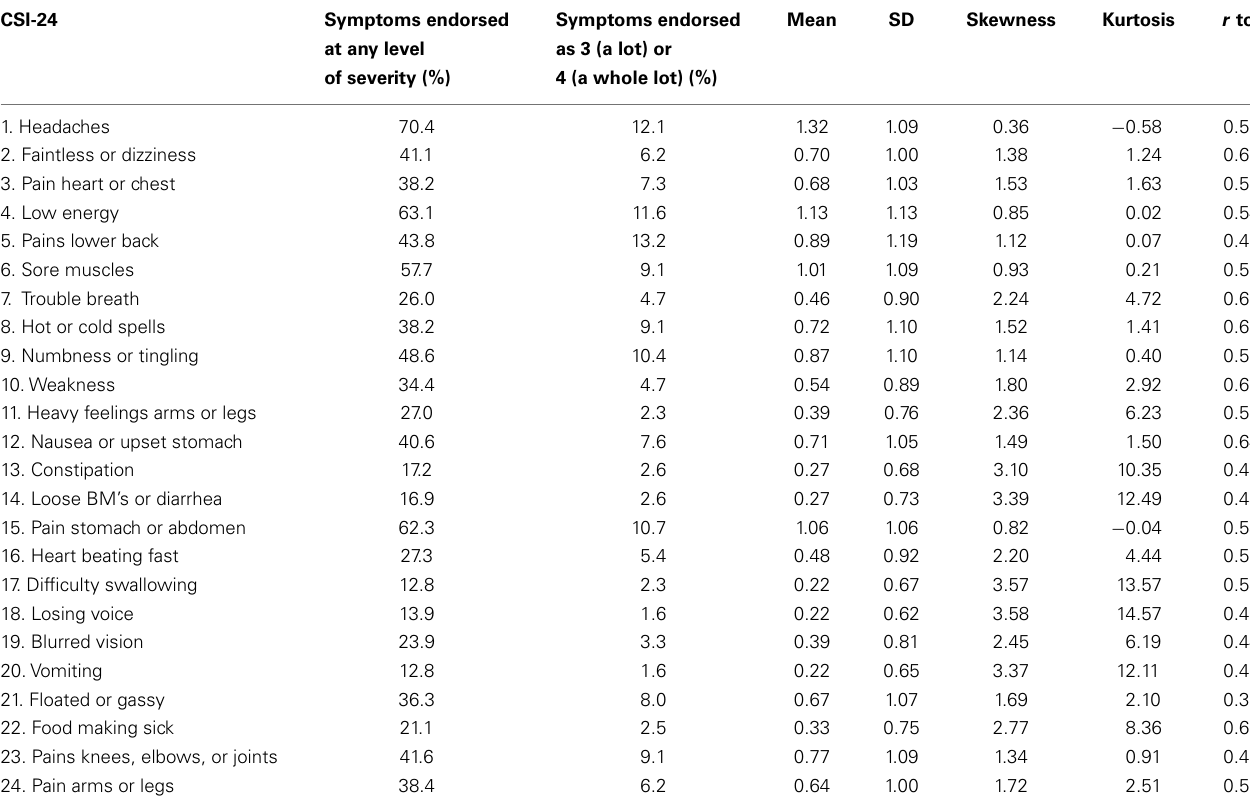
Table 1 | Characteristics of all the CSI-24 items.